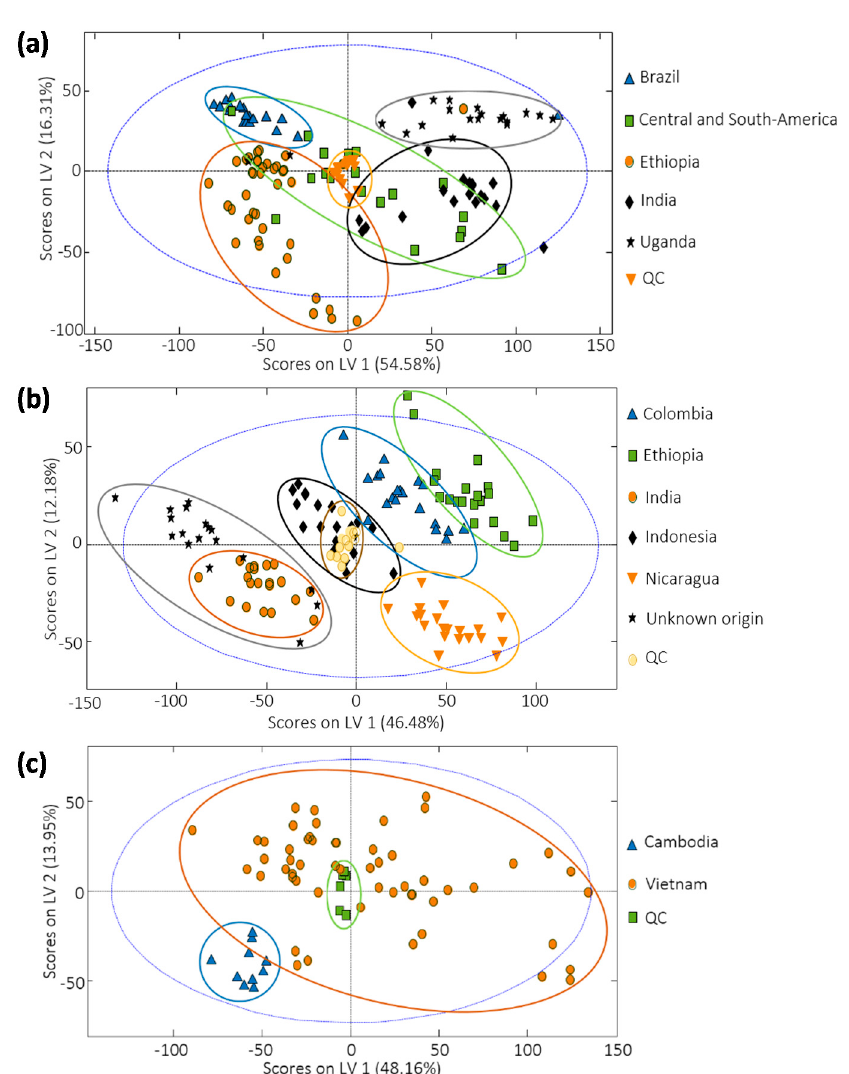
Figure 4. Partial least square regression-discriminant analysis (PLS-DA) score plots of LV1 vs. LV2 for ( a ) coffee set of samples 1, ( b ) coffee set of samples 2, and ( c ) coffee set of samples 3, when using chromatographic fingerprints to classify coffee samples according to their region of origin.